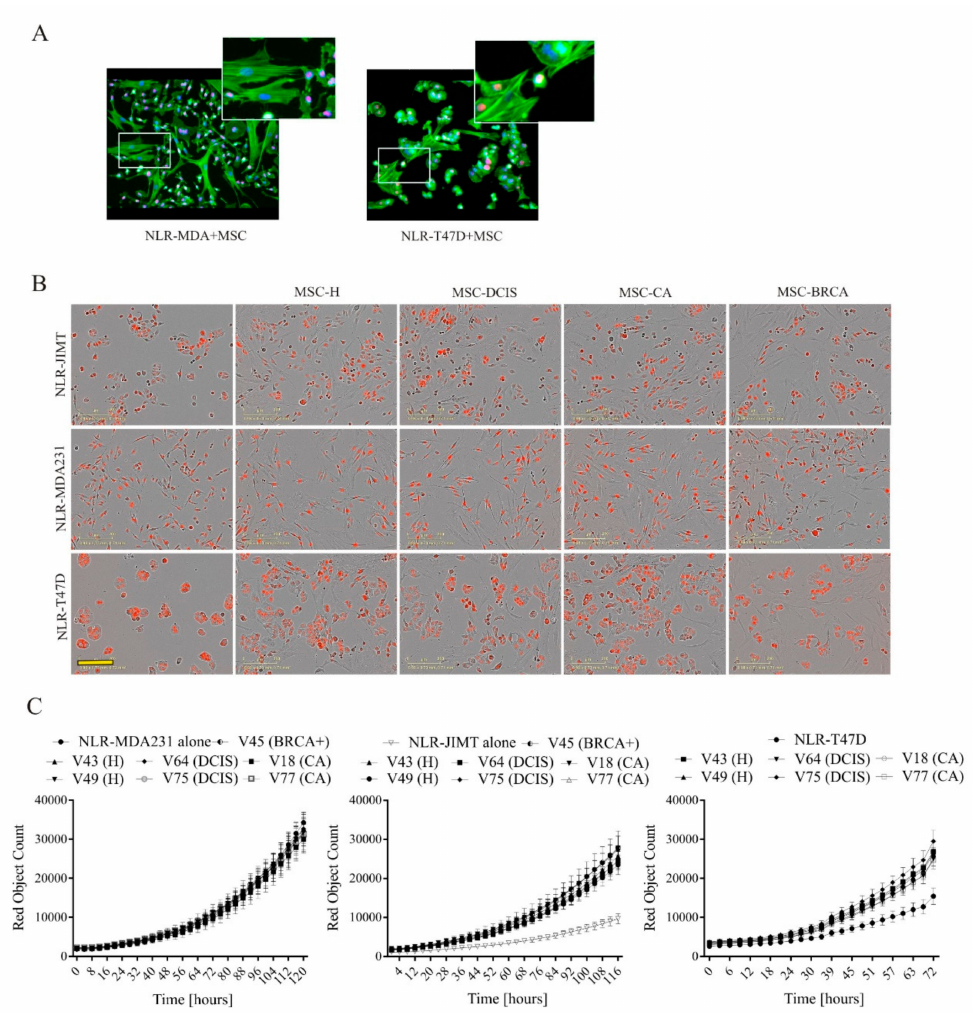
Figure 6. MSC–tumor cell interactions in 2D in vitro conditions. ( A ) Thin plasma membrane structures are formed between cancer cells and MSCs in co-culture allowing cell-to-cell communication and signaling. Magnification 200 × . Cytoplasmic actin was stained green, nuclei were stained with DAPI (blue). The nuclei of tumor cells also expressed red fluorescent protein, therefore they appear as magenta colored. ( B ) MSC co-culture with tumor cells expressing red fluorescent nuclear protein resulted in more mesenchymal-like cell morphology of co-cultured NLR-T47D and NLR-JIMT cells. Scale bar: 200 µ m. ( C ) Direct 7-day co-culture of NLR-JIMT and NLR-T47D breast cancer cells with MSCs of di ff erent origins highlighted the supportive role of MSCs in tumor cell proliferation, but no diagnosis-specific e ff ects on proliferation were observed. NLR-MDA231 proliferation was not enhanced by the presence of